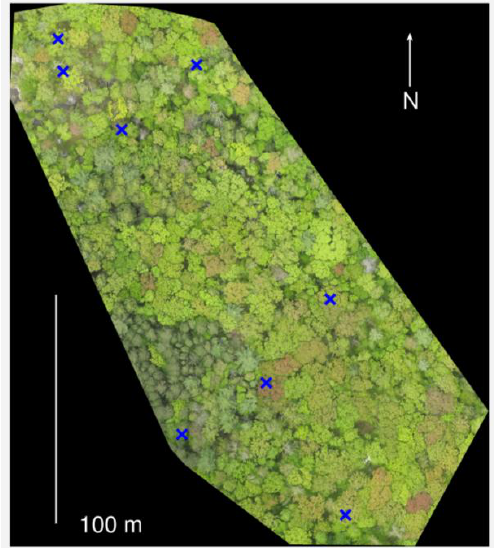
Figure 1. Study area at Harvard Forest on 5/21/17 (DOY 141). Location of microsite temperature loggers indicated as blue “×” symbols.